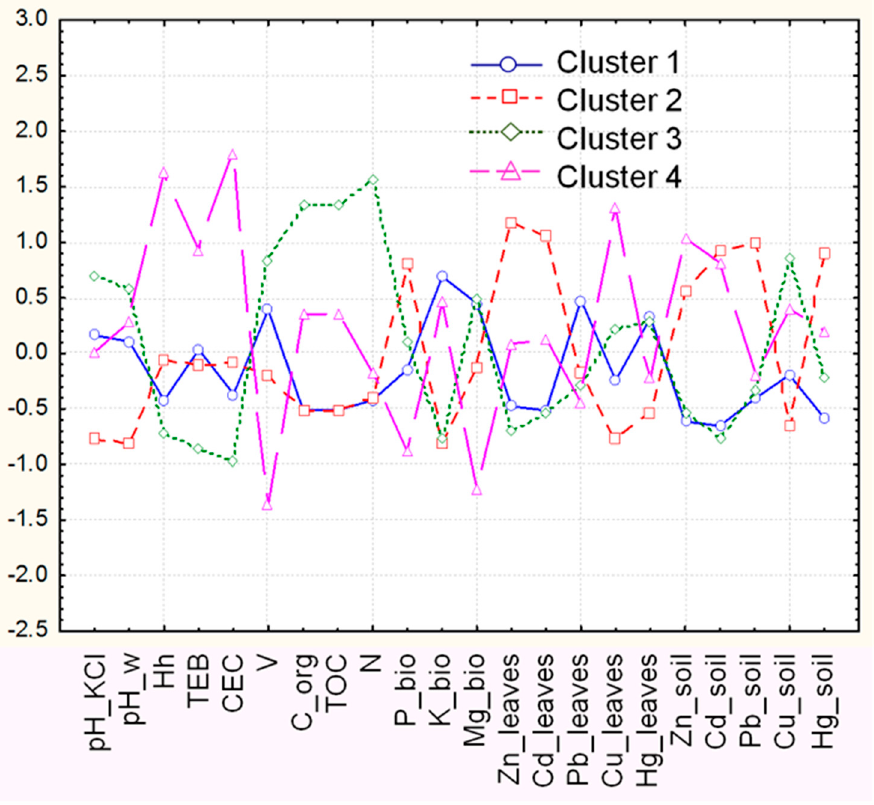
Figure 4. Averages (normalized) for each variable and for each cluster of locations.